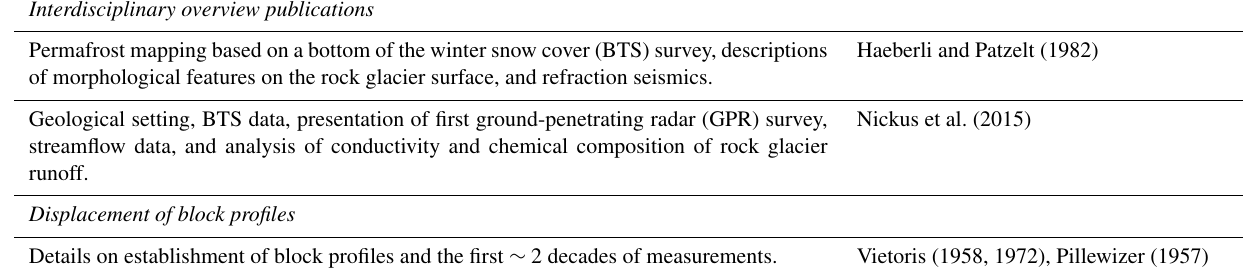
Table 1. Overview of previous studies at HEK rock glacier, grouped by thematic focus and listed chronologically per thematic group. Interdisciplinary overview